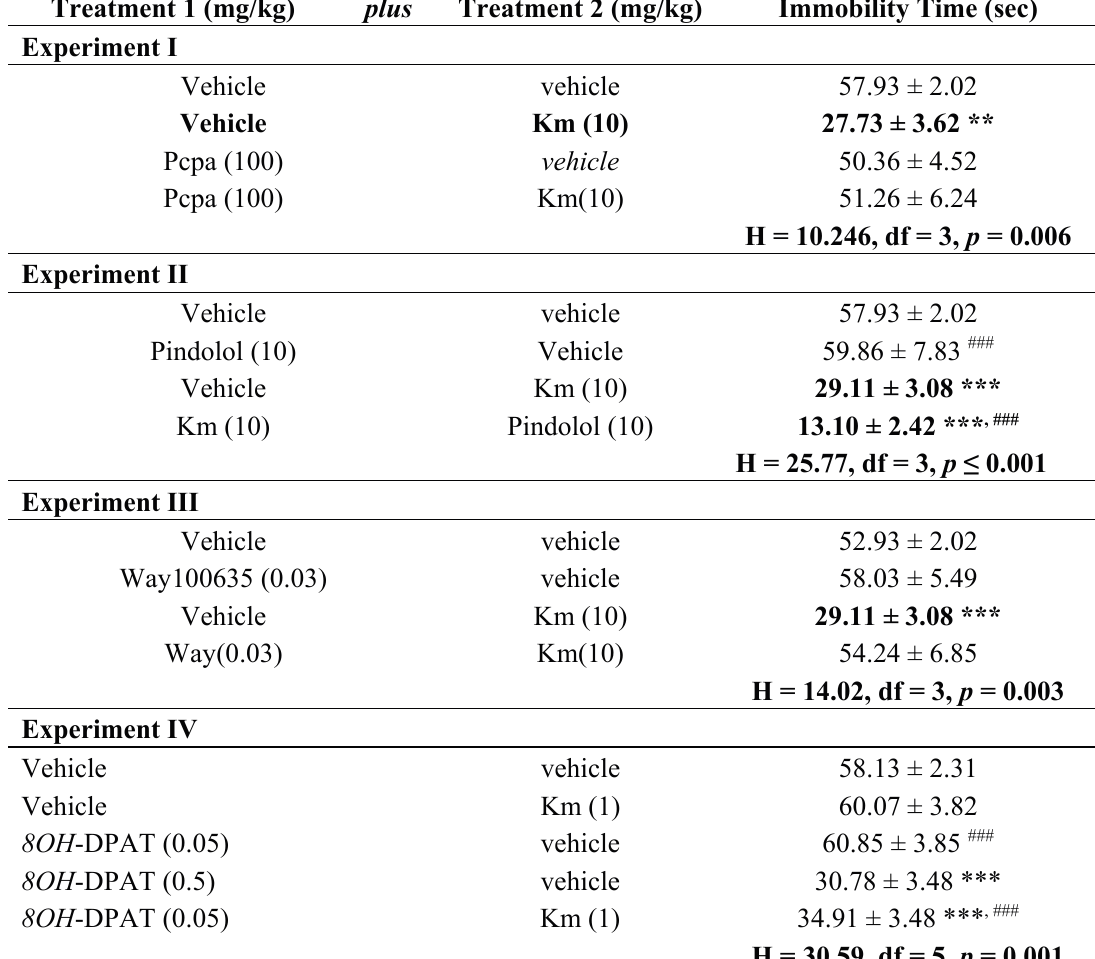
Table 2. Effect of PCPA, pindolol, WAY100635 and 8OH-DPAT on the immobility time of Km in FST of